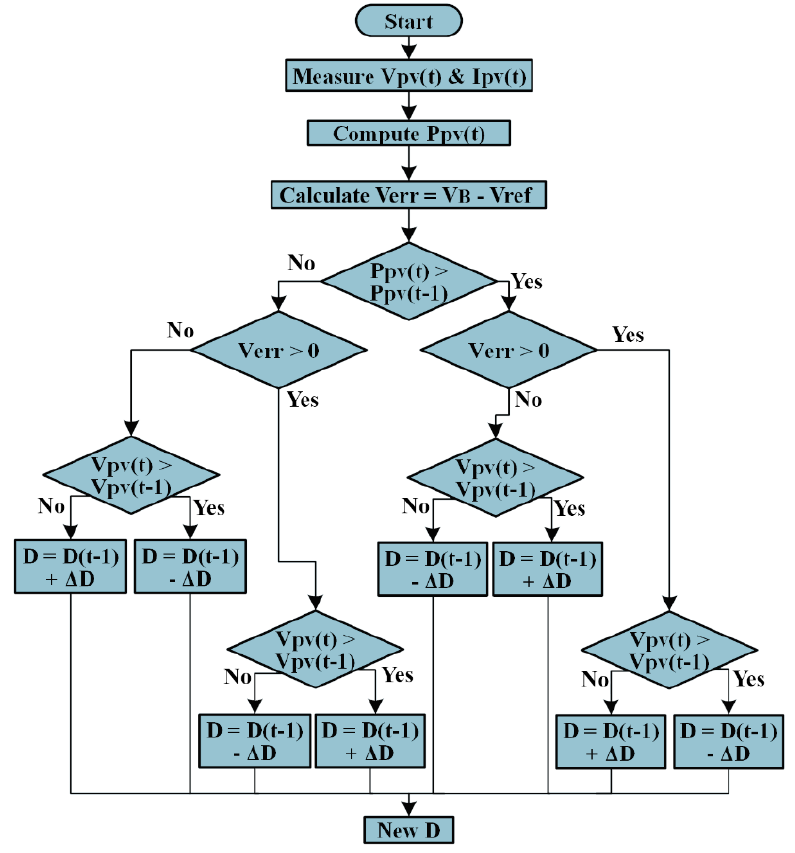
Figure 4. Flowchart of POVC.